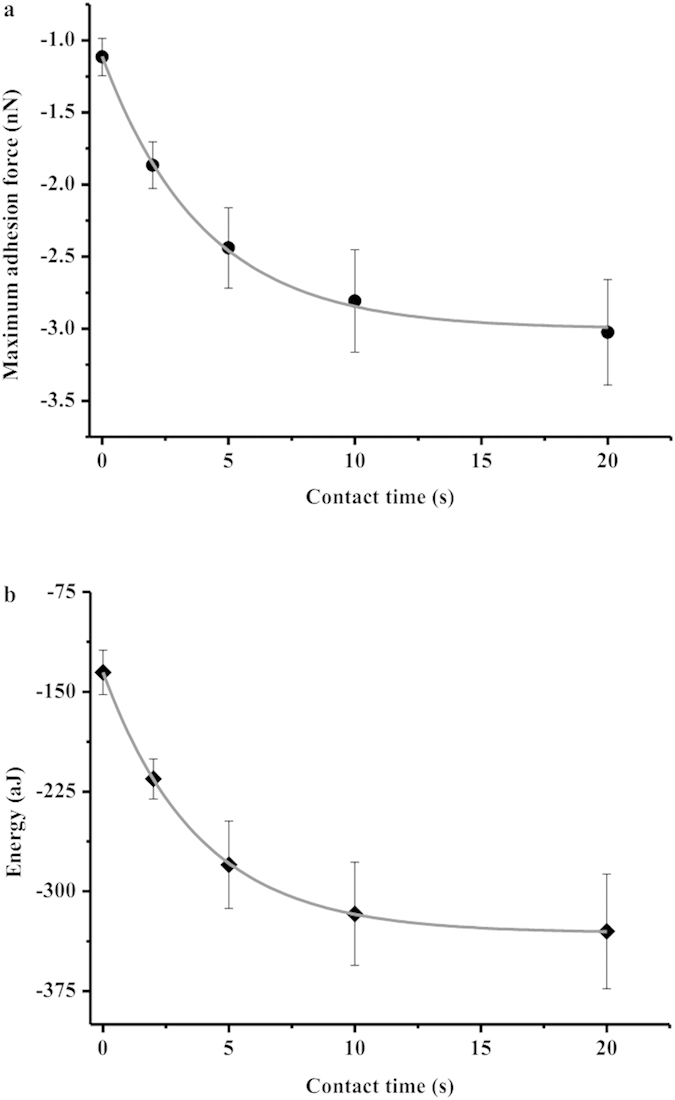
The maximum adhesion forces (a) and the adhesion energies (b) upon retraction of E. coli from goethite as a function of the surface contact time. Note that adhesion forces are in nanonewton and energy values are in attojoules (aJ = 10−18 J).